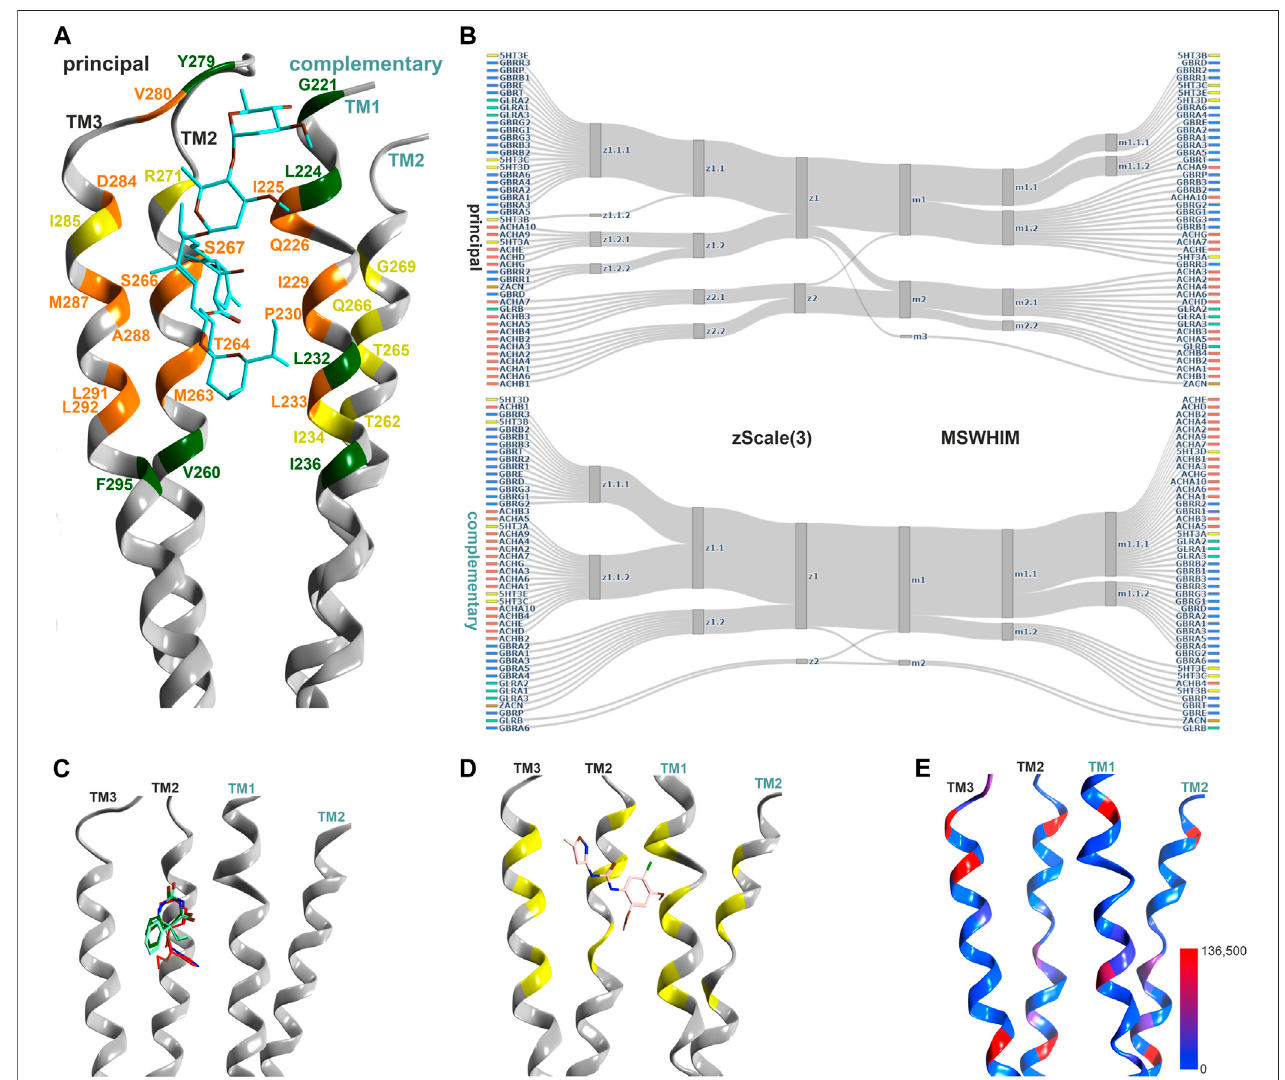
FIGURE4| RepresentativestructuresoftheupperTMDinterfacepocket,anddescriptoranalysis: (A) OverviewoftheTMDinterfacewithivermectin(cyansticks)in 5VDH. The ribbon segments that provide ligand contacts with ivermectin and with small molecules are orange, those with small molecule contacts only are yellow, and those with ivermectin only contacts are green. Amino acid numbering as in 5VDH. (B) Comparison diagrams for the subsite used by small molecules derived from hierarchical clustering of z-Scale(3) and MSWHIM descriptors as estimates for pocket similarities. Supplementary Figure S14A depicts the full dendrograms, Supplementary Figures S14B,C depict the analogous comparison for the ivermectin site. (C) Ribbon of the GABA A R β +/ α − structure with etomidate (6X3V in red), phenobarbital (6X3W in light- and dark-green). (D) 7EKT with PNU-120596. The yellow positions on the ribbon indicate the binding site forming segments which were used for panel (B) . (E) Amount of variants across all genes of interest in the region of this binding site mapped onto 7EKT. Ribbon heatmap represents the sum of minor allele counts per 100,000 at each aligned position. See Supplementary Figures S18,S19 for detailed heatmaps.